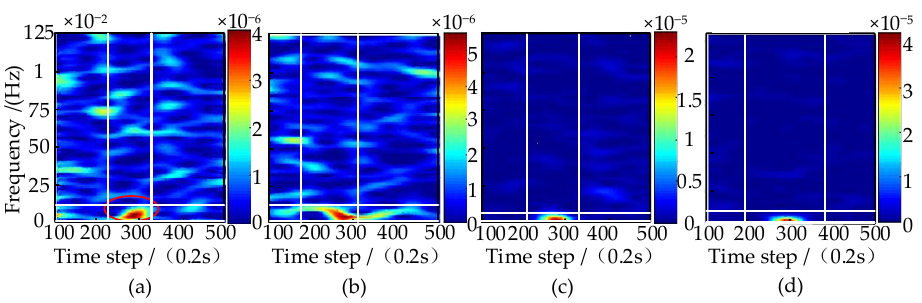
Figure 15. The frequency boundaries of the local region recognized by the STNED: ( a ) λ % = 10%; ( b ) λ % = 20%; ( c ) λ % = 30%; ( d ) λ % = 40%. As shown in Figure 15a, the white horizontal lines are frequency boundaries. It is obtained that the local region is enclosed by frequency boundaries. This phenomenon is also shown in Figure 15b–d. It indicates that the frequency boundaries delineated by the proposed STNED are consistent with the actual frequency boundaries of the local region. The methods proposed TFE, SPWVD+MV, SPWVD+SO, SPWVD+TH+SO, SPWVD+IPSE+SO, SPWVD+IPSE+SFPSE+SO, are used to extract fault features from the selected data shown in Figure 10a. For convenience, detailed descriptions of the methods are given in the followings. SPWVD+MV gets the time-frequency power spectrum of the signal based on SPWVD and takes the maximum value of the time-frequency power spec- trum as a fault feature. SPWVD+SO takes the sum of the entire time-frequency power spectrum as a fault feature. SPWVD+TH+SO sets a threshold and adds all the time-fre- quency power spectrums larger than the threshold together to form a fault feature. SPWVD+IPSE+SO identifies the time boundaries of the local region based on IPSE and takes the sum of the time-frequency power spectrum in the time boundaries as a fault feature. SPWVD+IPSE+SFPSE+SO recognizes frequency boundaries by the single